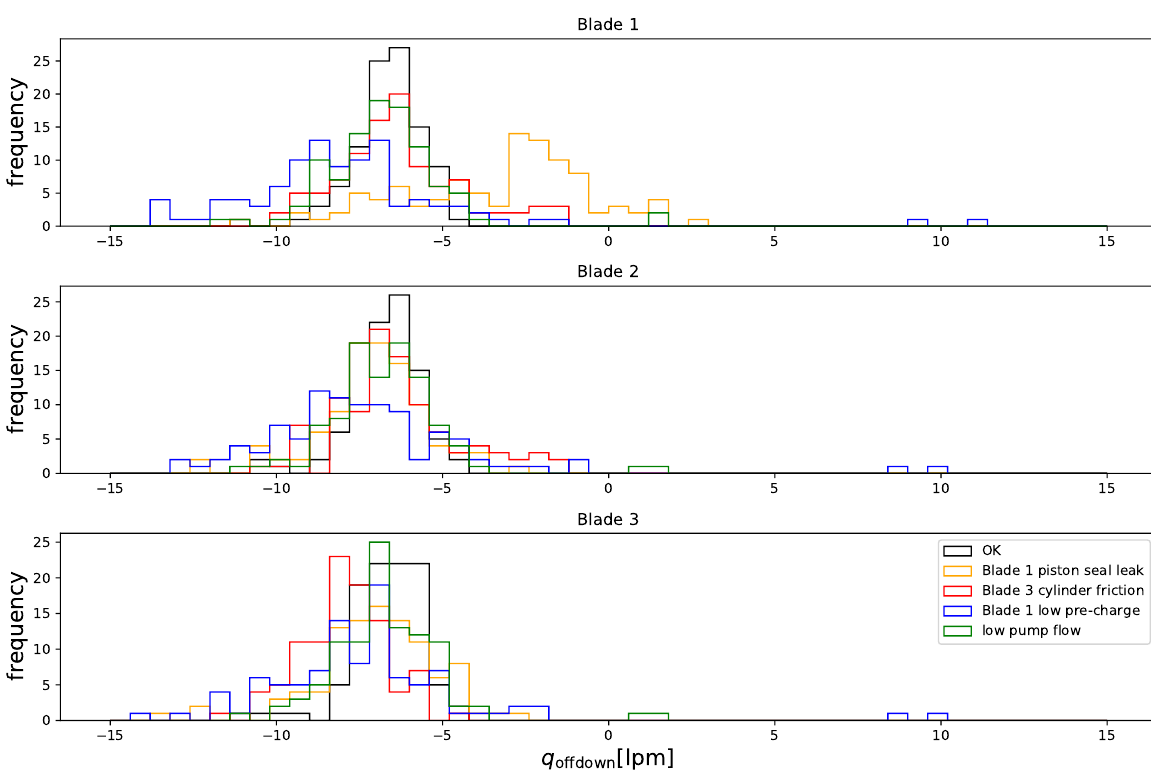
Figure 17. Simulation parameter distribution, q offdown